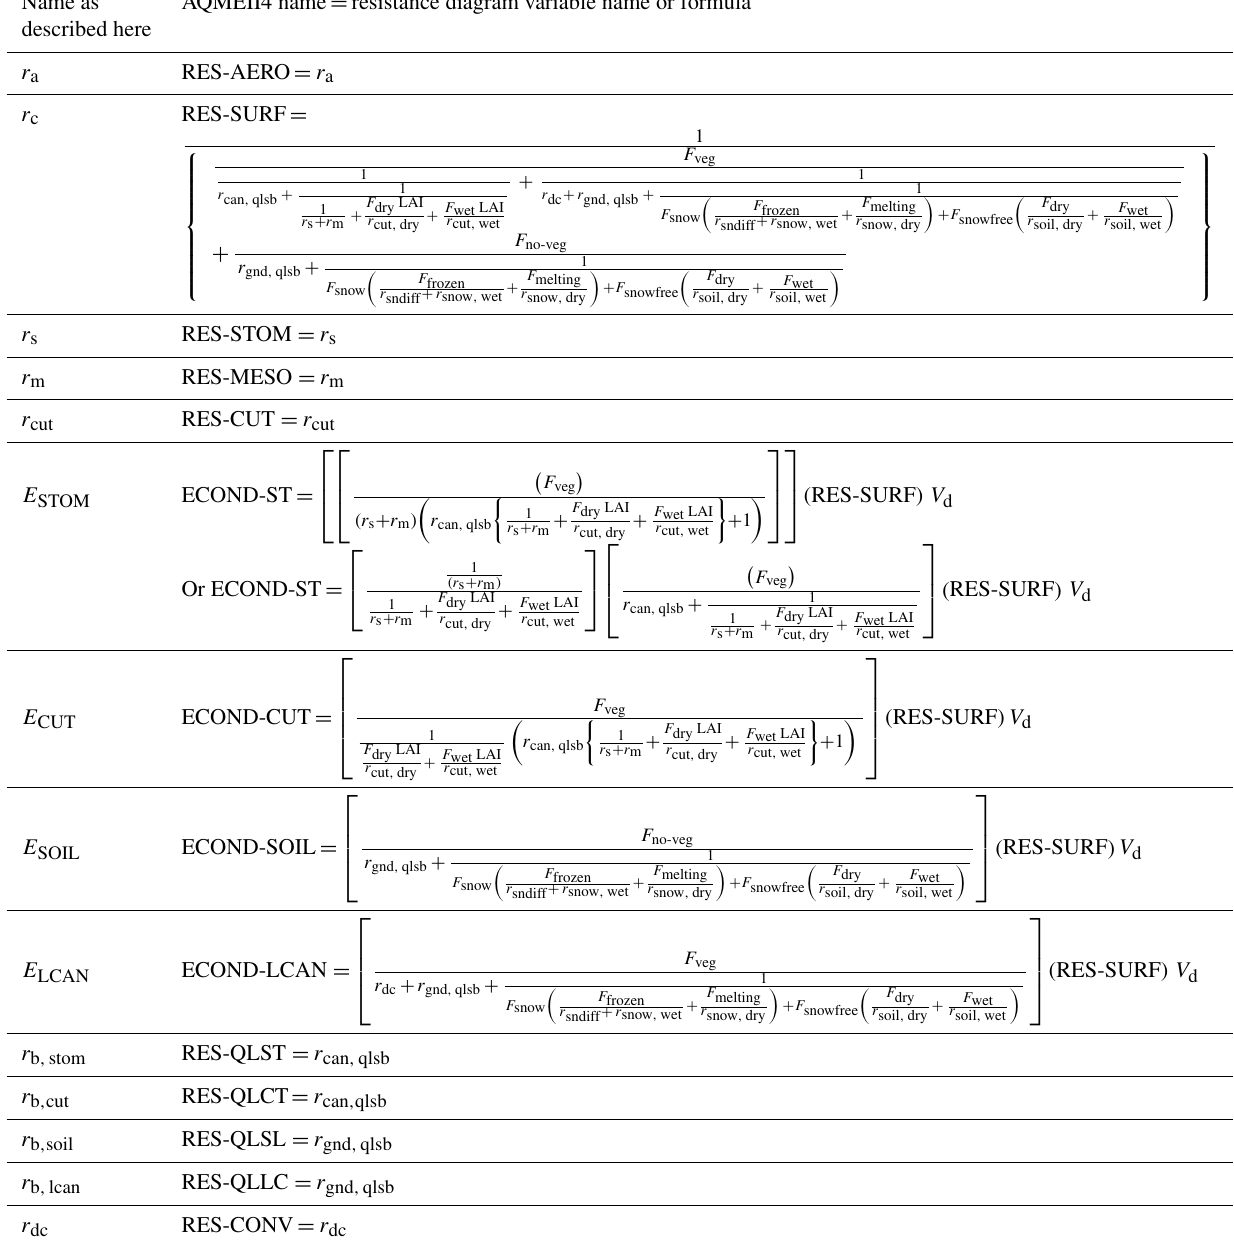
Table B3. AQMEII4-reported gaseous deposition variables corresponding to the CMAQ STAGE resistance model of Fig. B3. Name as AQMEII4 name = resistance diagram variable name or formula described